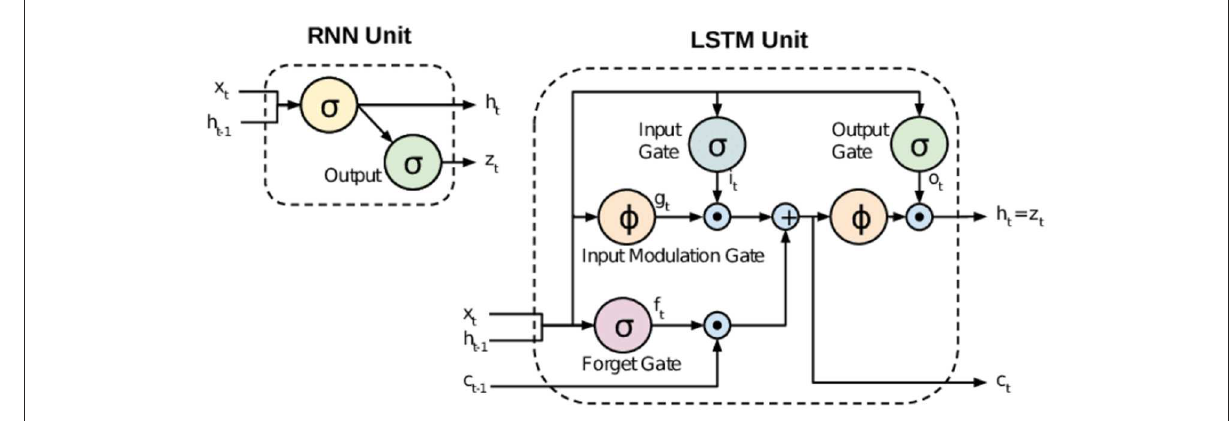
FIGURE3 Comparison between RNN and